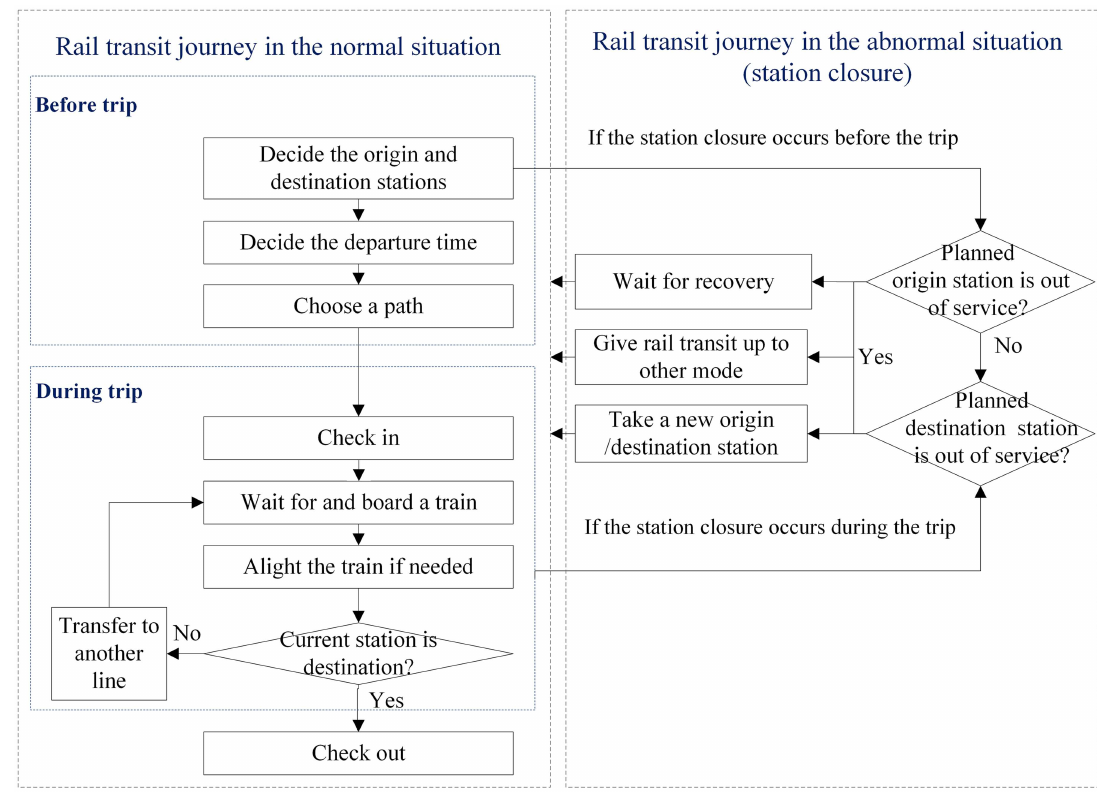
Fig 1. A schematic diagram indicating the passengers’ travel behavior along a rail transit journey in the normal and abnormal conditions. A detaileddescription is presentedin the previous paragraphand the next paragraph. In addition,this logic diagram is a qualitative summary of passengertravel behaviorin a rail transit network and is originallypresentedin this